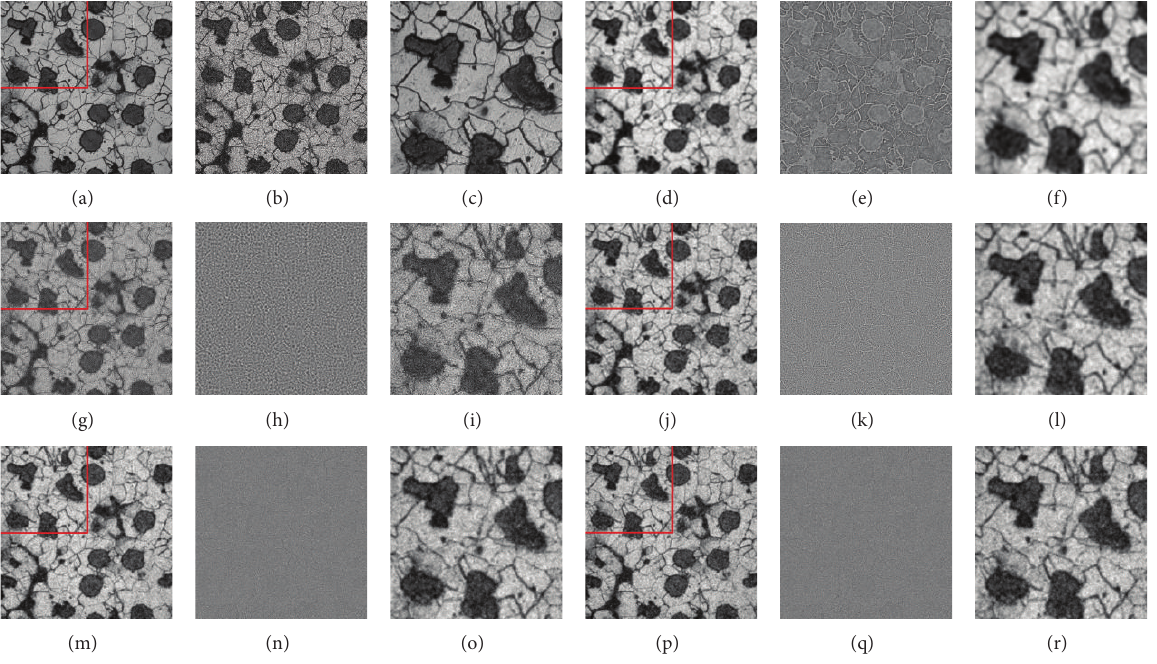
Figure 5: Denoising effects of texture-rich metallographic image of iron ball. (a) Original clean image, (b) noisy image (adds white Gaussian noise to the original clean image, PSNR = 13.6872), (c) partial enlarged details of 1/4 party of (a) red box, (d) denoised image of bilateral filtering denoising [88, 89, 93], (e) residual plot of bilateral filtering denoising, (f) partial enlarged details of 1/4 party of (d) red box, (g) denoised image of wavelet denoising [92, 93], (h) residual plot of wavelet denoising, (i) partial enlarged details of 1/4 party of (g) red box, (j) denoised image of NLMF denoising [94, 95], (k) residual plot of NLMF denoising, (l) partial enlarged details of 1/4 party of (j) red box, (m) denoised image of FDM denoising ( V 1 = 1.75 , V 2 = 2.25 , V 3 = 1.05 , Δ𝑡 = 10 −10 ), (n) residual plot of FDM denoising, (o) partial enlarged details of 1/4 party of (m) red box, (p) denoised Image of FDM denoising ( V 1 = 2.25 , V 2 = 2.5 , V 3 = 1.25 , Δ𝑡 = 10 −10 ), (q) residual plot of FDM denoising, (r) partial enlarged details of 1/4 party of (p) red box. Table 2: Comprehensive denoising effects results for texture-rich metallographic images of an iron ball. Denoising effect Denoising algorithm PSNR Correlation coefficients Contrast Correlation Energy Homogeneity Noisy image 13.6872 Bilateral filtering denoising 20.4845 Wavelet denoising NLMF denoising FDM denoising FDM